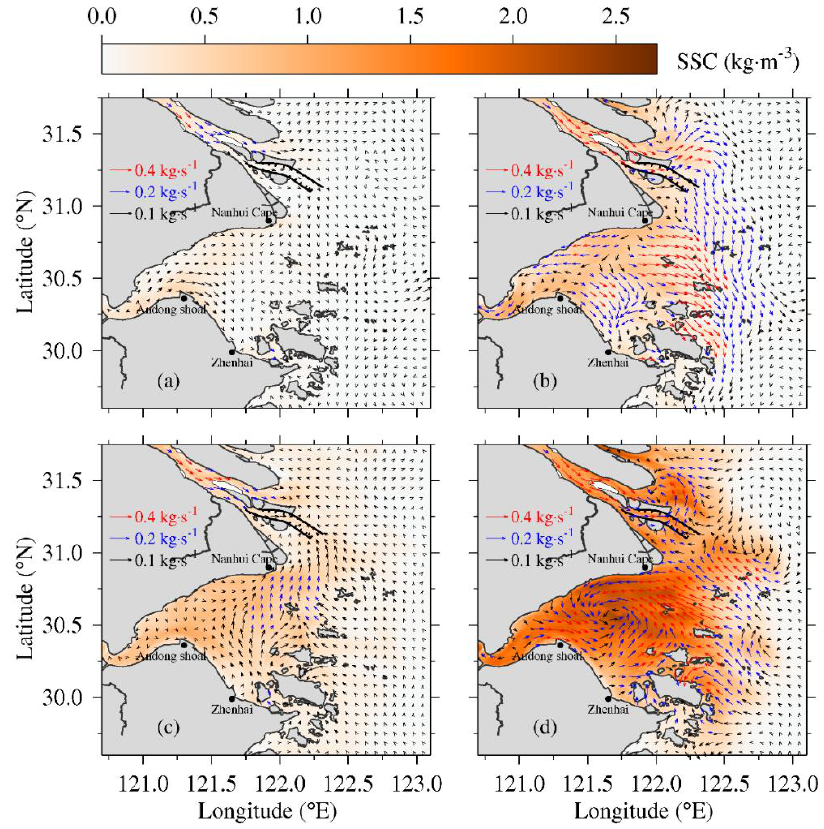
Figure 11. Distribution of the RUSF and SSC in the surface layer (upper panel) and bottom layer (lower panel) during neap tide ( a , c ) and spring tide ( b , d ) in summer (color images represent SSC and arrows represent RUSF).